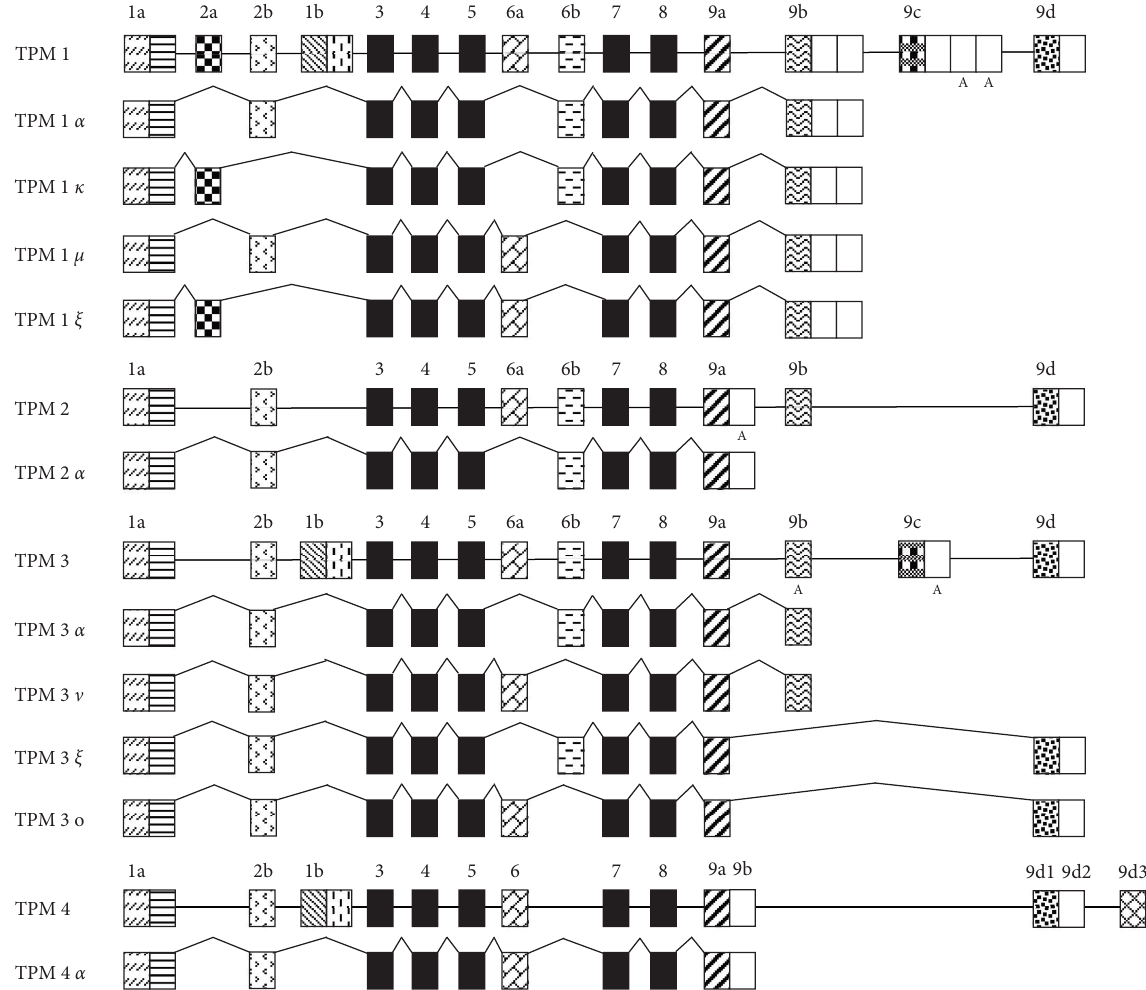
Figure 9: Alternative splicing patterns of TPM genes in human/nonhuman primates that generate high molecular weight isoforms. Exon compositions of TPM1, TPM2, TPM3, and TPM4 are derived from various published documents, the recently submitted data, and the predicted sequences available in Gen Bank. Exons are shown in